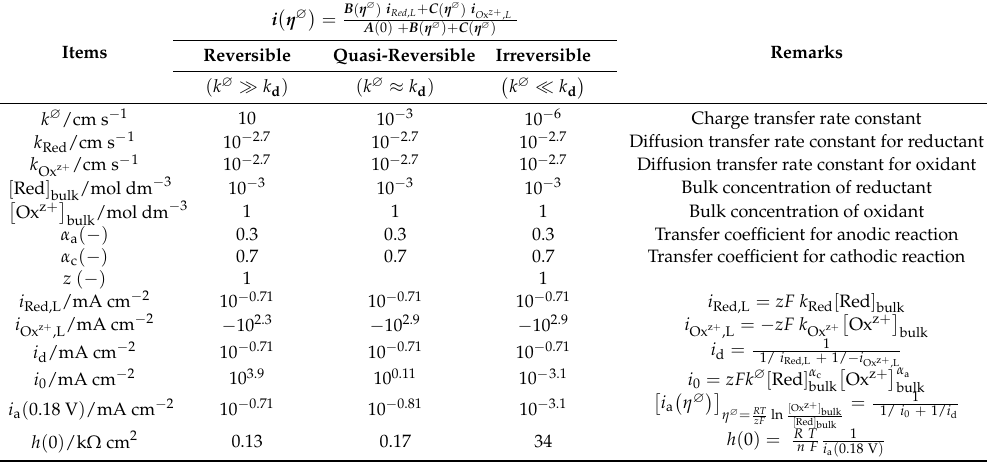
Table 1. Example data for drawings for graphical explanation of the i here are explained in the